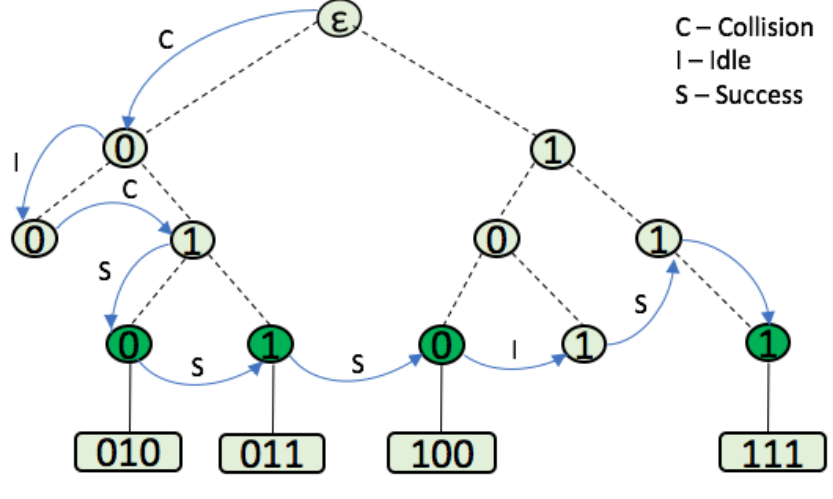
Figure 2. Example of the STT